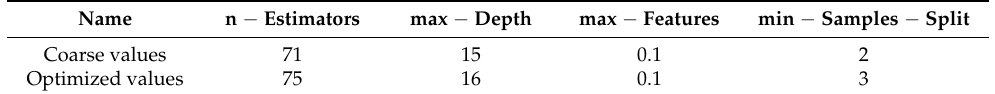
Table 4. Main parameters of RF algorithm.